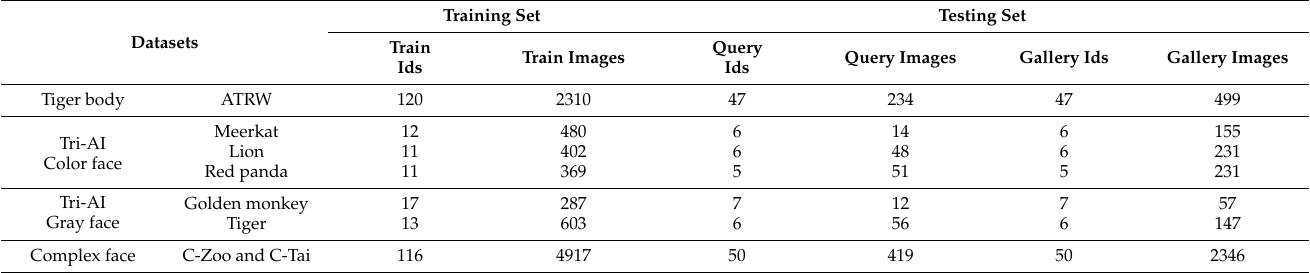
Figure 1. Examples of images from the dataset. Table 1. Statistics of the training set and test set for the re-ID task.